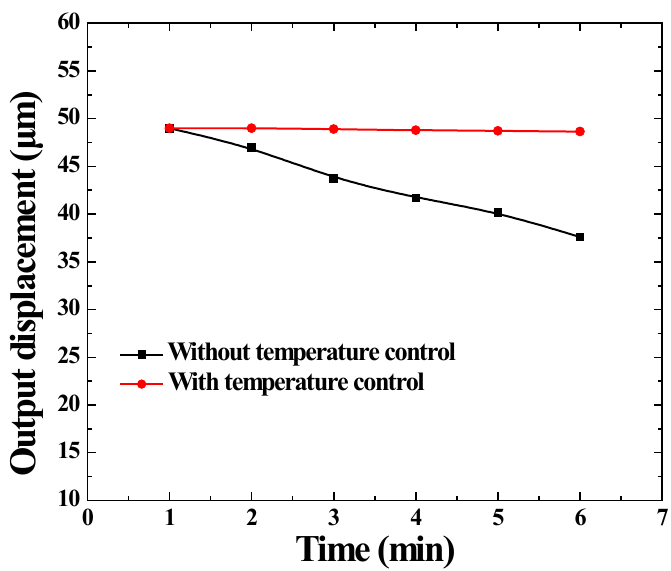
Figure 11. Output displacement of the GMT. The amplitudes of the output displacement are measured at a working of 1–6 min when the GMT with the temperature-control system works at 6000 Hz, a 2A driving current and 0.5 m/s flow velocity of the silicone oil. The maximum amplitude is 49 µ m at continuous working of 1 min. The minimum amplitude is 48.35 µ m at a continuous working of 6 min. It can be concluded that the output-displacement deviation is controlled for less than 0.65 µ m. The deviation is 1.3%. When there is no temperature-control